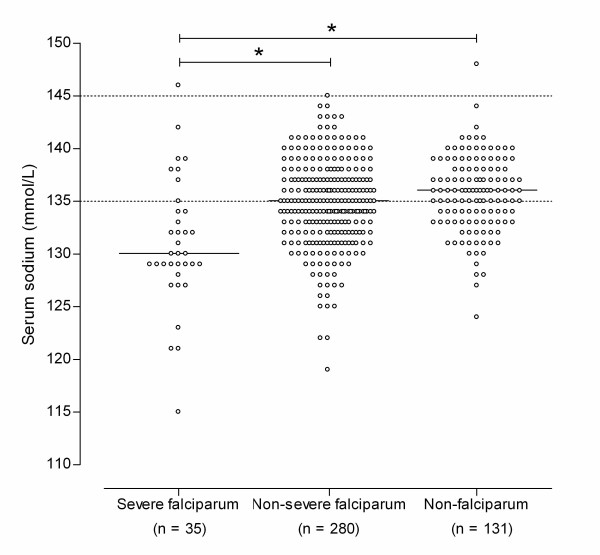
Distribution of serum sodium in malaria patients grouped by causative Plasmodium species. Hyponatraemia was present in 27/35 (77%) of patients with severe P. falciparum infection, in 135/280 (48%) of patients with non-severe P. falciparum infection, and in 45/131 (34%) of patients with non-falciparum infection. Dashed lines indicate normal reference range. Bars indicate the median.